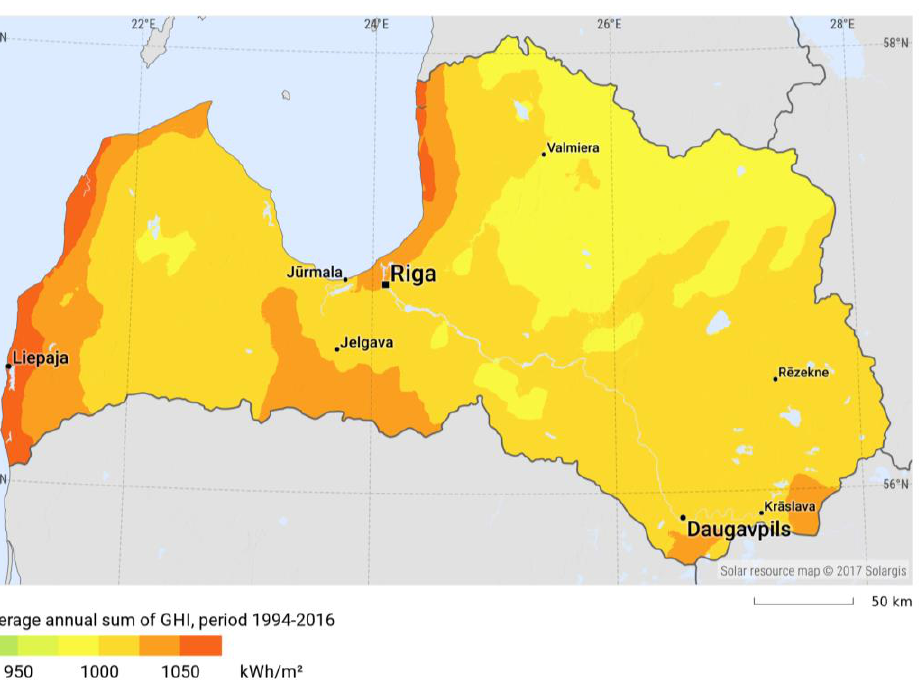
Fig. 1. Global horizontal irradiation in Latvia